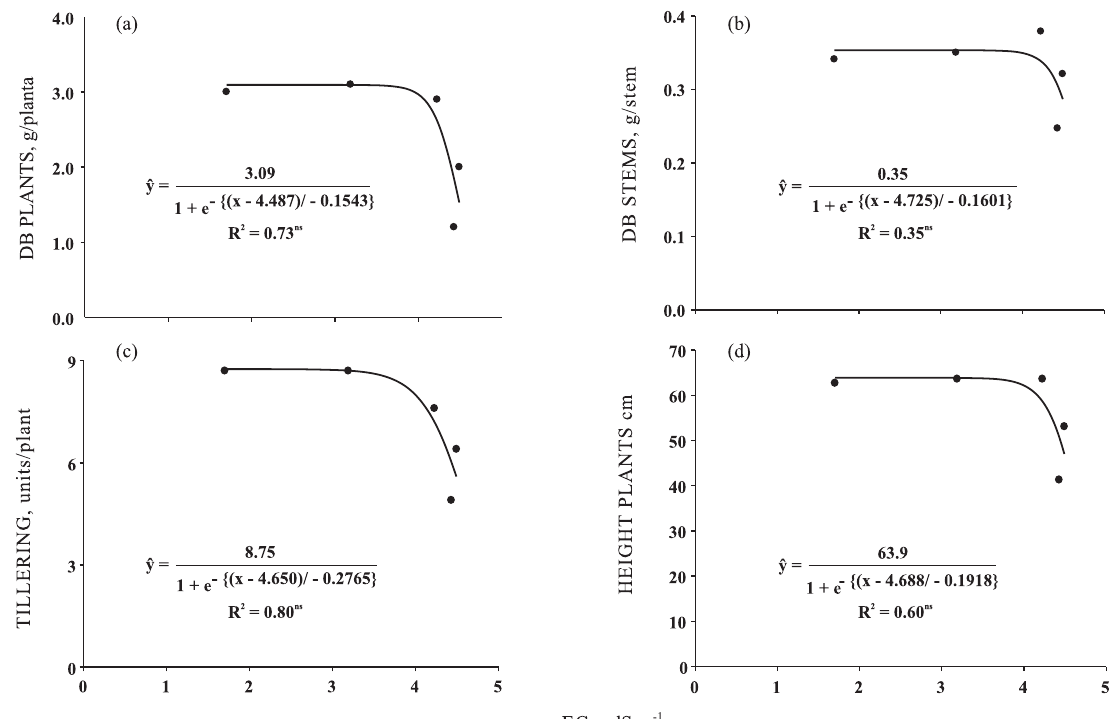
Figure 4. Dry biomass (DB) of plants (a) dry biomass of stems (b), tillering (c) and height (d) of rice plants, according to the electrical conductivity of the soil solution (ECe) at the end of the